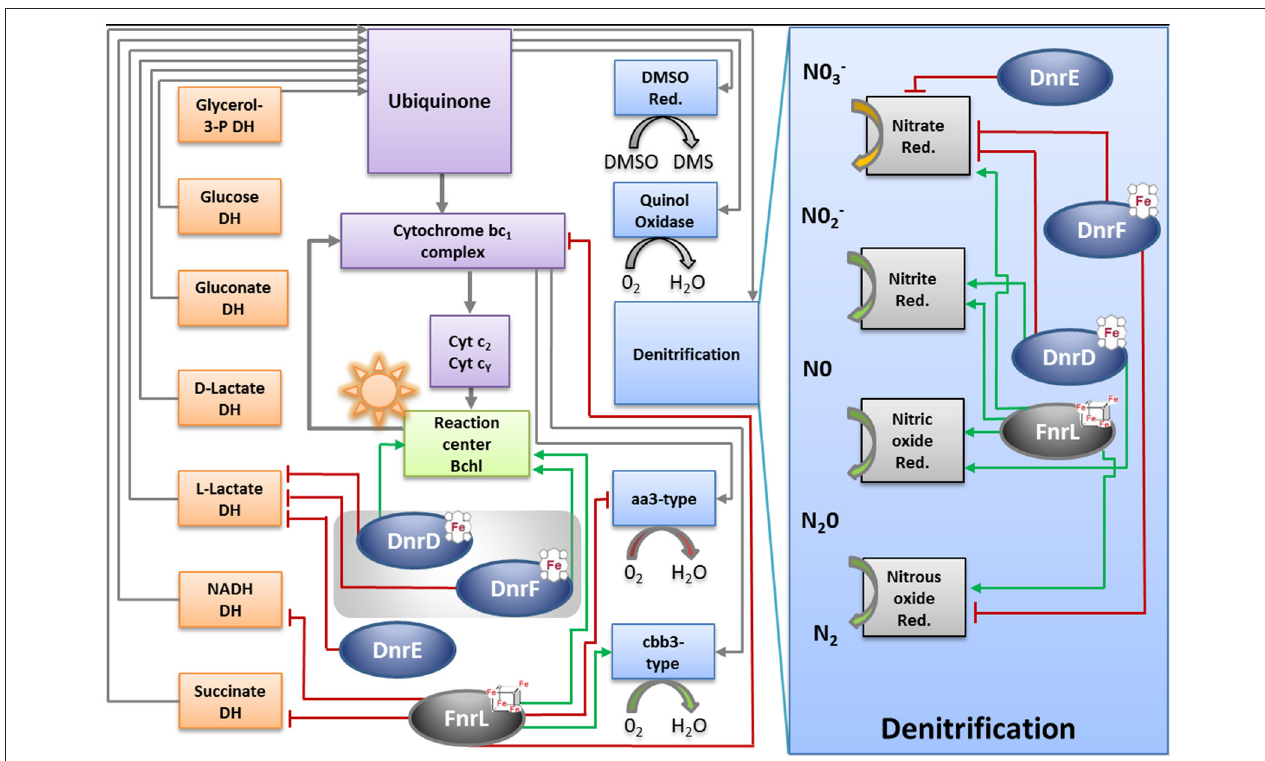
FIGURE 8 | Model for the regulation of the energy metabolism of D. shibae by FnrL, Dnr D, DnrE and DnrF during the aerobic to anaerobic transition. DH, dehydrogenase; Cyt, cytochrome; bchl, bacteriochlorophyll; Q d and Q b oxidized and reduced form of reaction center quinone, respectively; Cox, cytochrome oxidase; DMSO, dimethyl sulfoxide; Red, reductase. Figure was adapted from Wagner-Döbler et al.